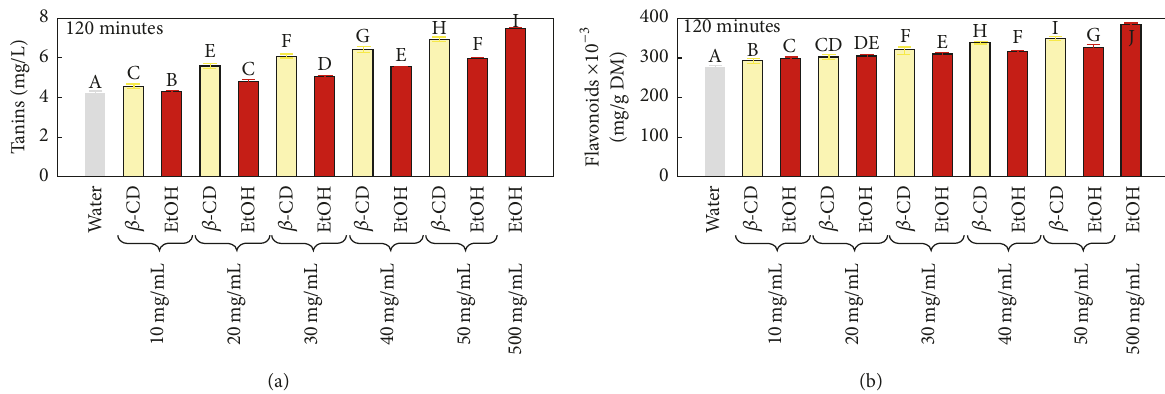
Figure 2: Comparison of (a) tannins and (b) flavonoids recovery using 𝛽 -CD and EtOH at the same concentrations after 120 minutes of extraction. Different superscript letters indicate significant statistical difference ( 𝑝 < 0.05 ).